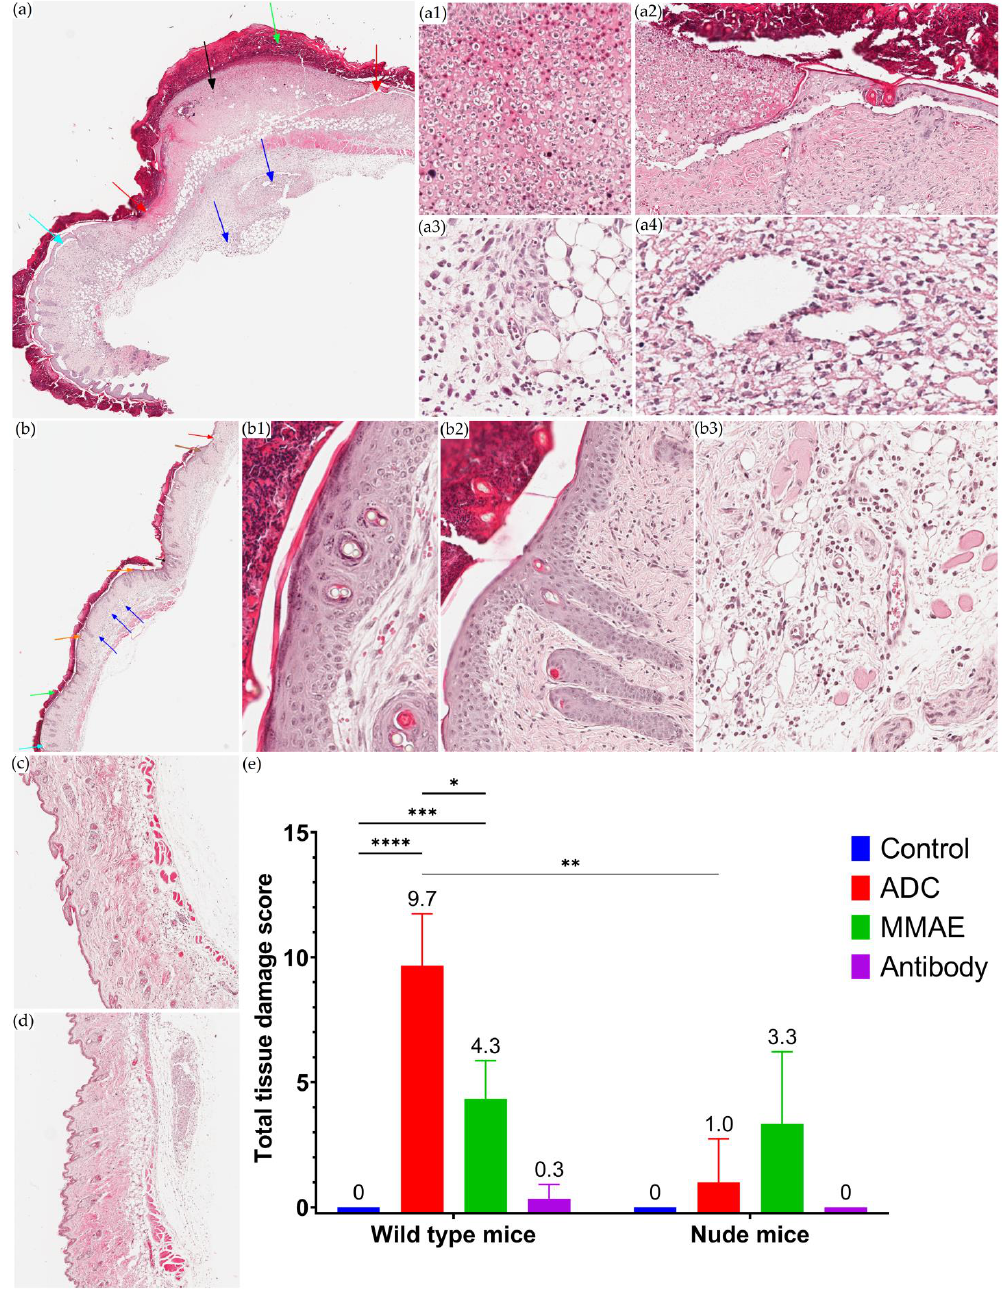
Figure 6. Local toxicity of subcutaneously administered ADC in wild-type mice. Representative histopathology in wild-type mice that received: ( a ) 30 mg/kg of T-vc-MMAE single-dose subcuta- neously, ( b ) 0.5 mg/kg of MMAE single dose subcutaneously, ( c ) 30 mg/kg of trastuzumab single dose subcutaneously, and ( d ) vehicle control subcutaneously. The microscope magnification was 20 × . Tissue damage is indicated by arrows displaying necrosis (black), ulceration (red), inflammatory infiltrate (blue), hyperkeratosis (green), blisters (cyan), acanthosis (brown), and hypergranulosis (orange). The tissue damage shown includes necrosis ( a1 ), ulceration ( a2 ), inflammatory infiltrate ( a3 , a4 ) are shown. The represented tissue damage of hypergranulosis ( b1 ), acanthosis ( b2 ), inflam- matory infiltrate ( b3 ) are shown. ( e ) The histogram displays total tissue damage scores (mean and SD) calculated by summation of severity scores (0~3) of blister formation, inflammatory infiltrate, ulceration, and necrosis; * p < 0.05, ** p = 0.005, *** p = 0.0005, **** p <